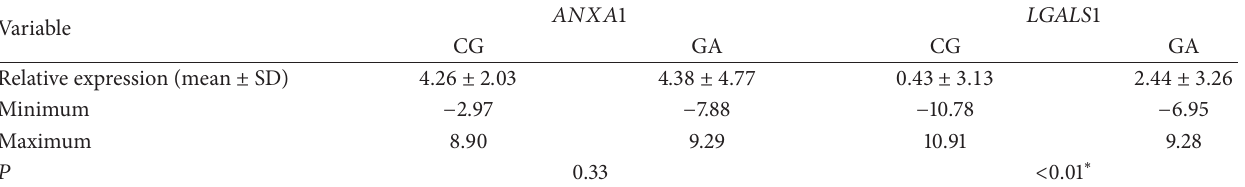
Table 3: Comparison of ANXA1 and LGALS1 mRNA relative expression levels between the chronic gastritis (CG) and the gastric adenocar- cinoma (GA) groups.